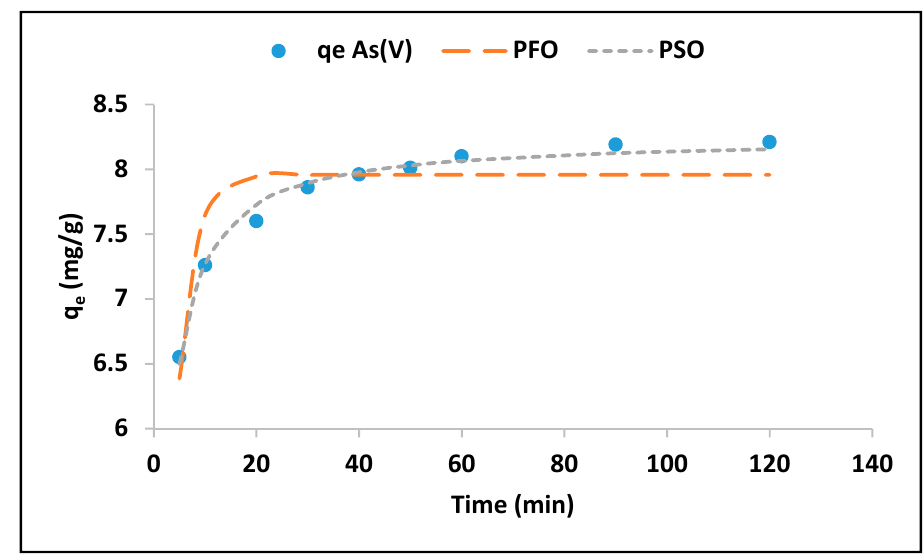
Figure 2. Effect of contact time on the adsorption of As(V) and adsorption kinetics.